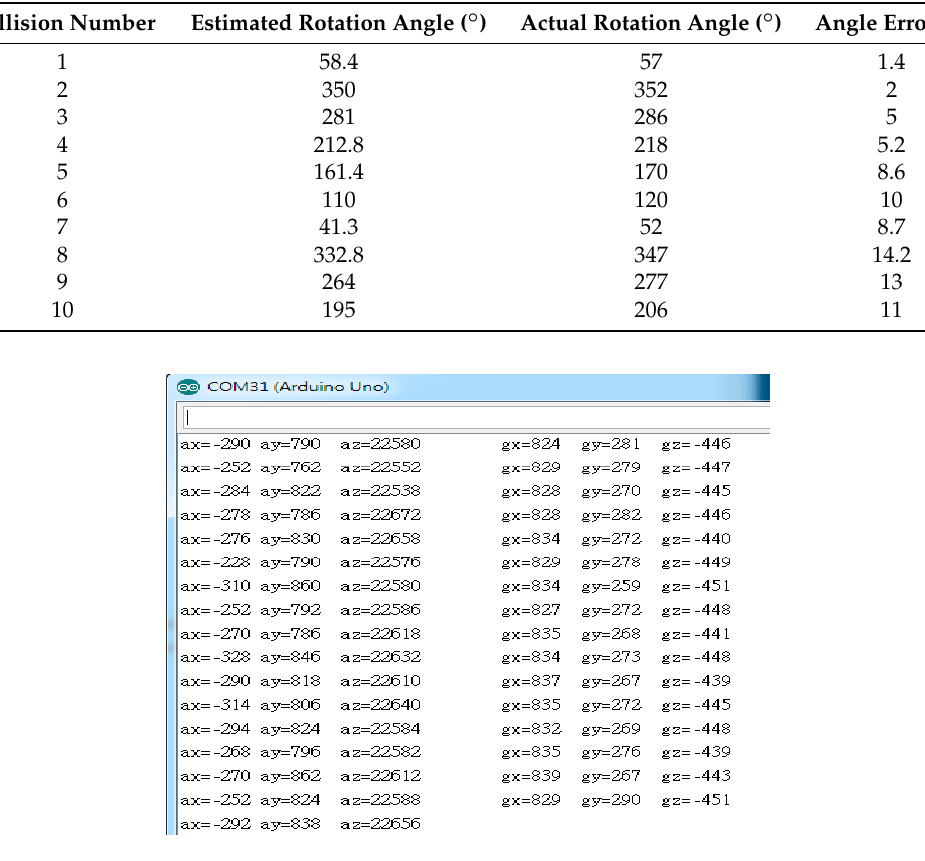
Table 8. Collision angle offset without adding six-axis sensor.